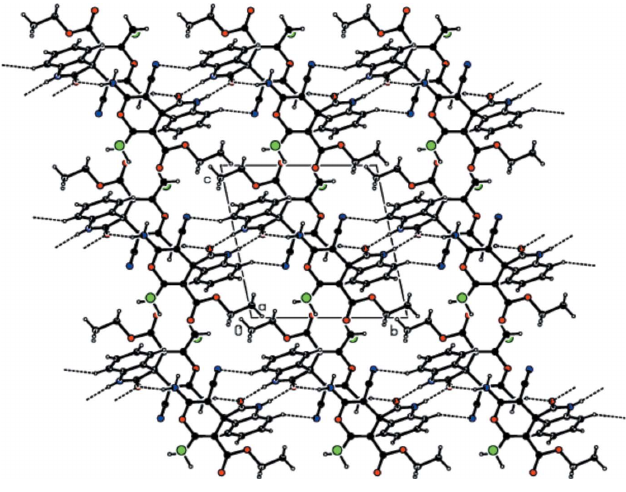
Figure 3 A view of the intermolecular N—H (cid:2)(cid:2)(cid:2) O and C—H (cid:2)(cid:2)(cid:2) N hydrogen bonds in the crystal packing of the title compound down the a